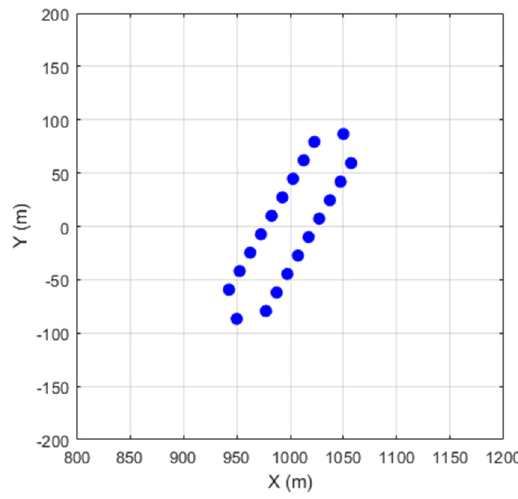
Figure 4. Point-like vessel target.